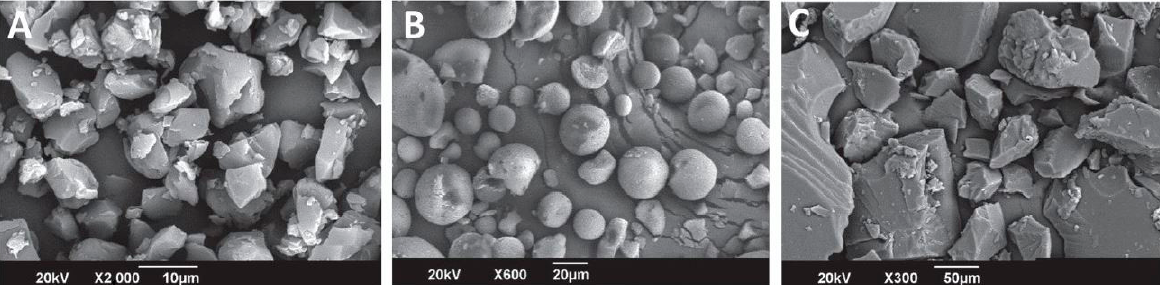
Figure 5. SEM images of ( A ) amorphous Eudragit EPO, ( B ) spherical Eudragit L100, ( C ) amorphous stoichiometric IPEC of EPO/L100 (Adapted with permission from [119], Scientific Electronic Library Online, Brazil, 2018.)